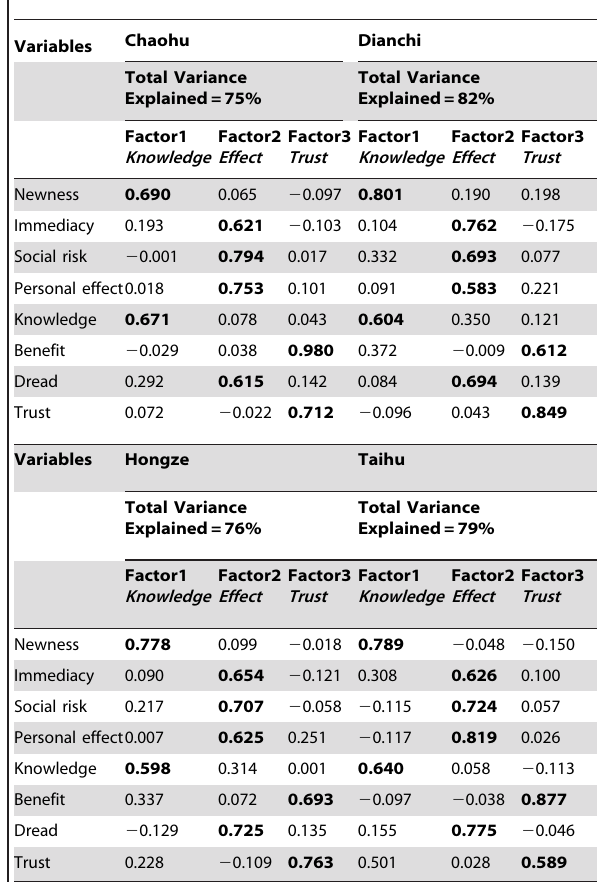
Table 7. Factor Analysis Results of Risk Characteristics about HABs in Four